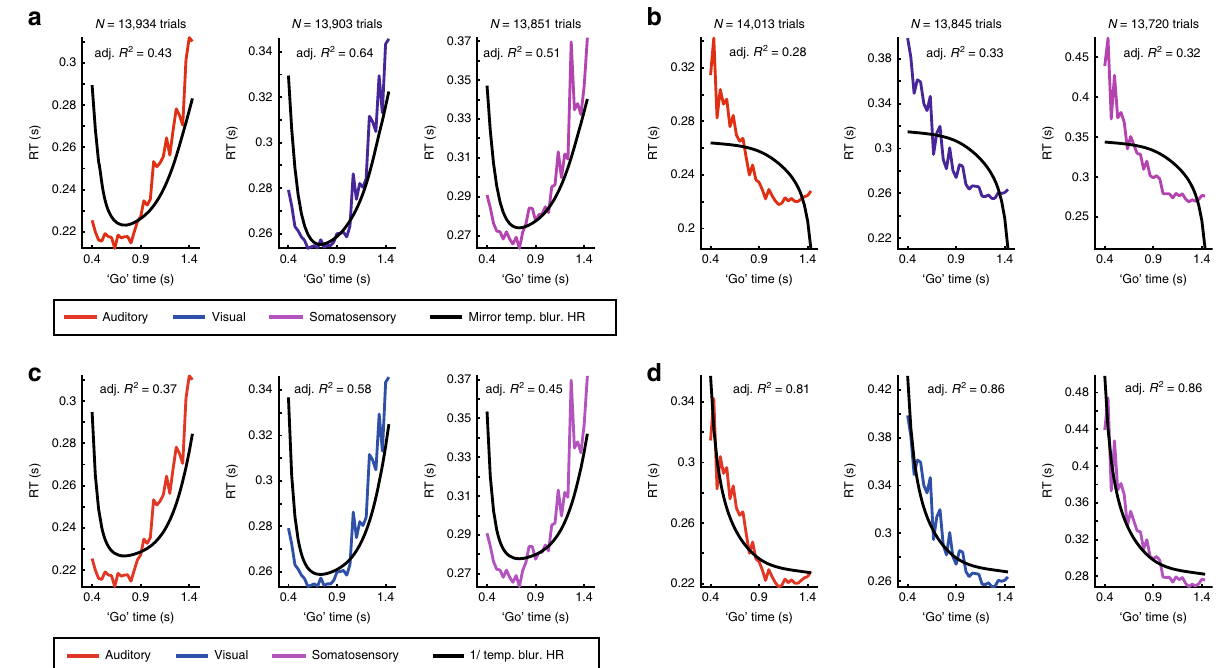
Fig. 3 Models based on the hazard rate (HR) fail to capture reaction time (RT) data. a The commonly used temporally-blurred HR (black line) in its linearly transformed ( “ mirror ” ) version fi tted to auditory (red), visual (blue), and somatosensory (violet) RT data from PD Exp condition. The HR model deviates from RT in the early range of ‘ go ’ times. b As a but for PD Flip condition. Note the substantial, qualitative mismatch between the HR model and the RT data. c Fits of the temporally-blurred, reciprocal ( “ 1 / ” ) HR to RT in the PD Exp condition. The fi t at the early ‘ go ’ times is not improved by the reciprocal model, compare with a . d As c but for PD Flip condition. The reciprocal relationship between HR model and RT improves the fi t in the PD Flip condition, compare with c . See Supplementary Figs. 1 and 2 for detailed summary of all other fi tted HR-based